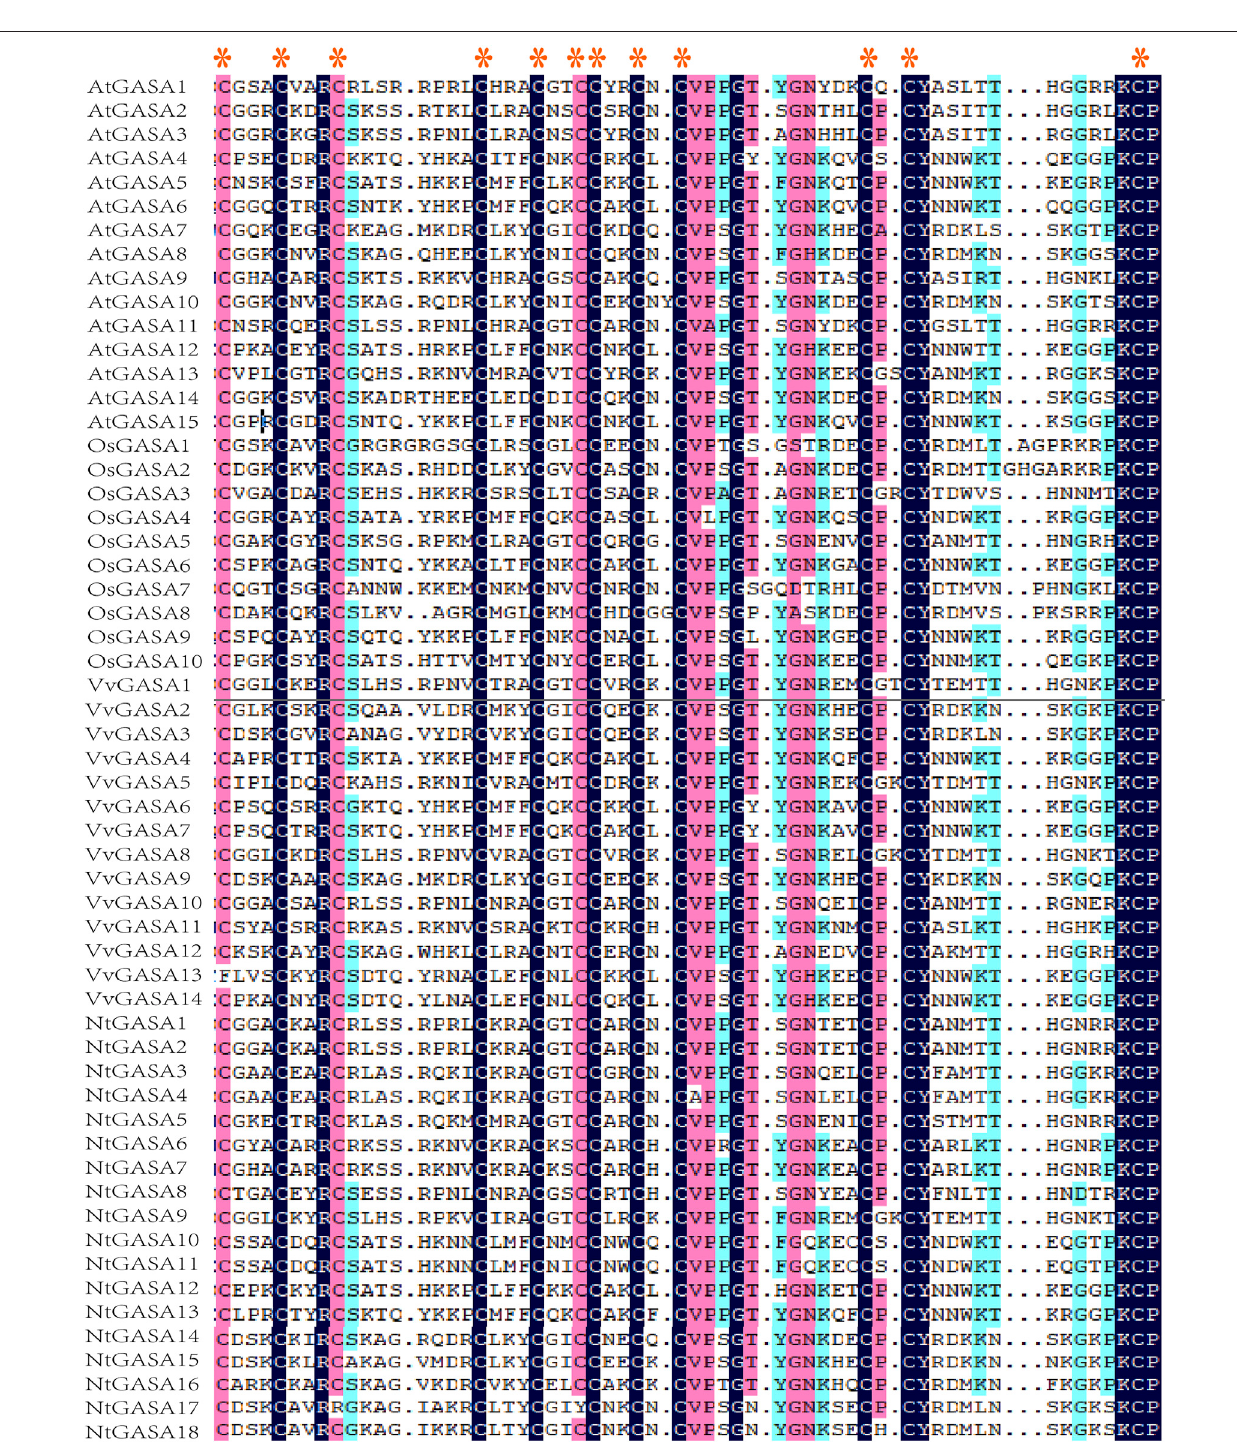
Frontiers in Genetics |